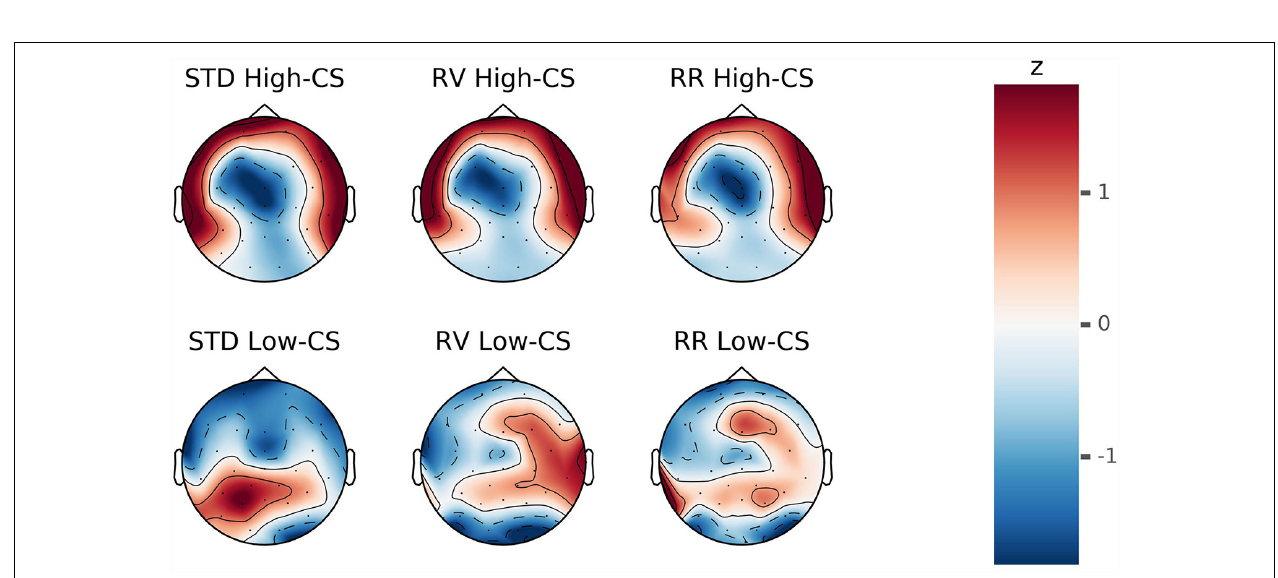
FIGURE 6 | Response-locked event-related potentials (ERPs) for correct responses at electrode FCz for both conscientiousness (CS) groups separated by instruction conditions. The three panels show the ERPs of standard (STD), rule violation (RV), and rule reversal (RR) conditions, respectively. Color-shaded areas indicate the 95% confidence intervals for the mean ERPs. Gray-shaded areas mark the time windows of CRN and Pc.